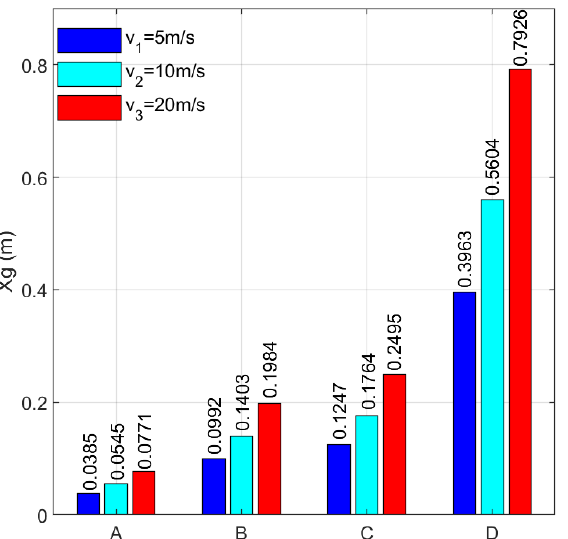
Figure 3. Comparison of RMS values of road displacement under different working conditions.